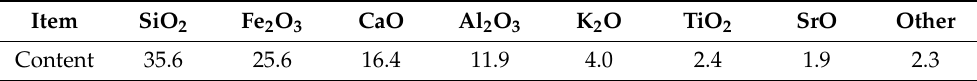
Figure 3. Distribution curves of the particle size ( a ) and the X-ray diffraction (XRD) pattern of the FA ( b ). Table 2. Chemical composition content of FA (unit: wt.%).